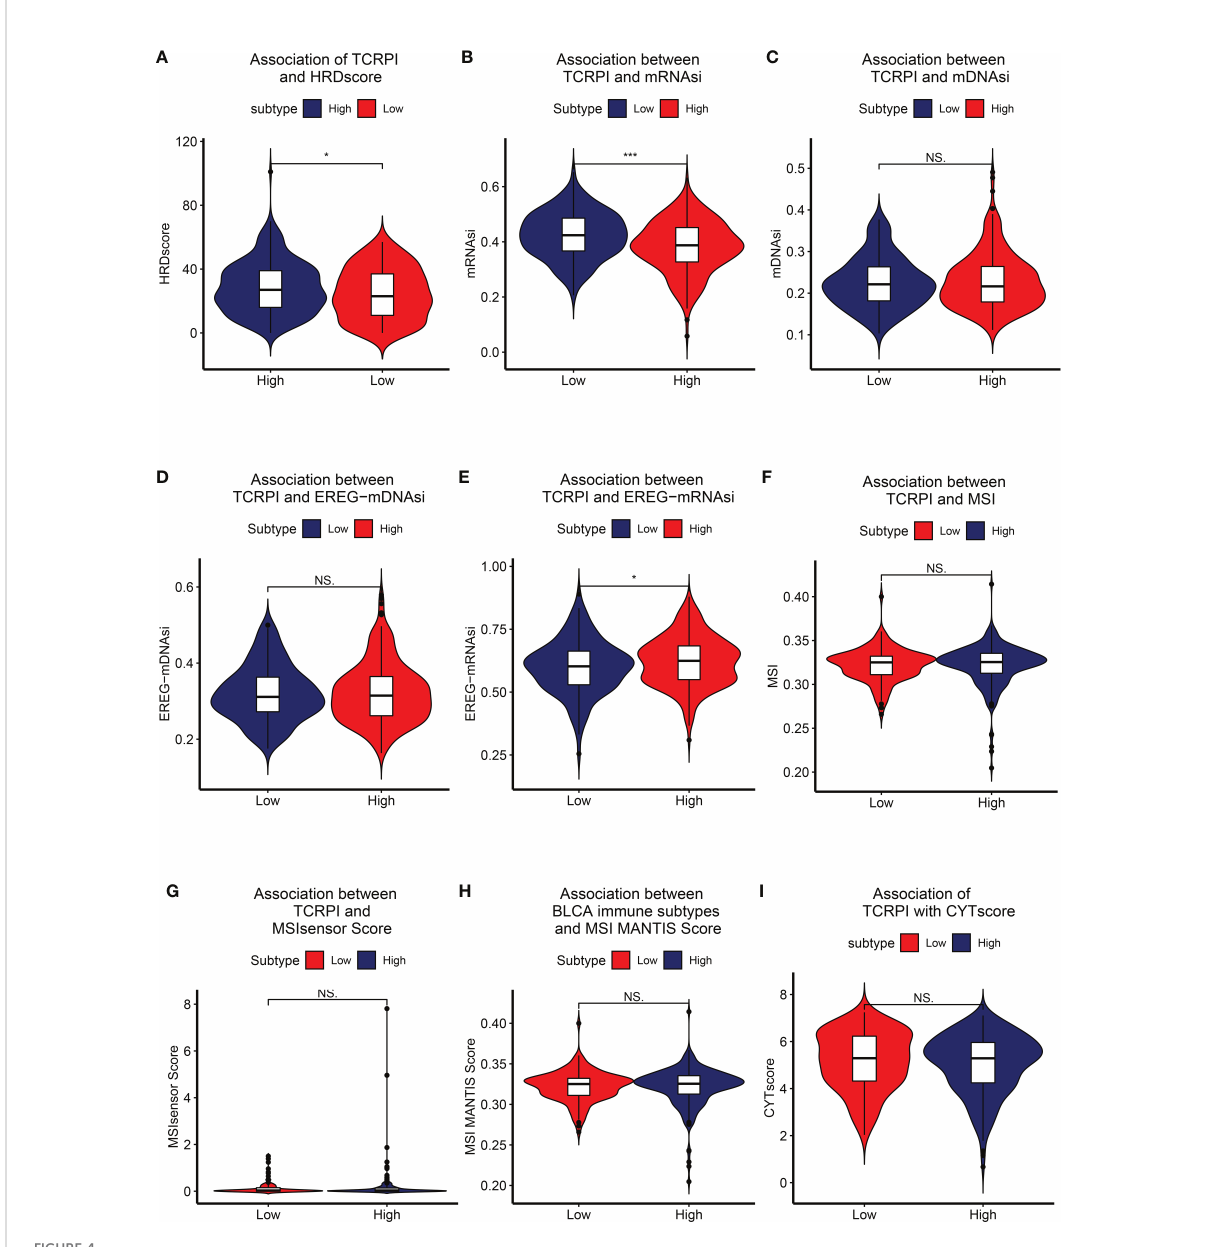
FIGURE 4 Association of TCRPI with other highly trustworthy indices. (A) HRDscore. (B) mRNAsi. (C) mDNAsi. (D) EREG-mDNAsi. (E) EREG-mRNAsi. (F) MSI. (G) MSI sensor score. (H) MSI MANTIS score. (I) CYT score. NS, no signi fi cance, *P <0.05, ***P